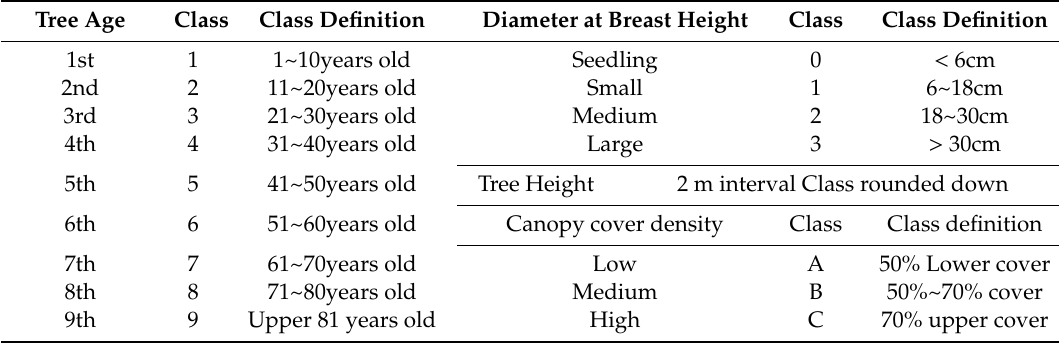
Table 3. Tree age, diameter at breast height, tree height and canopy cover density class definitions used in the forest type map of South Korea.